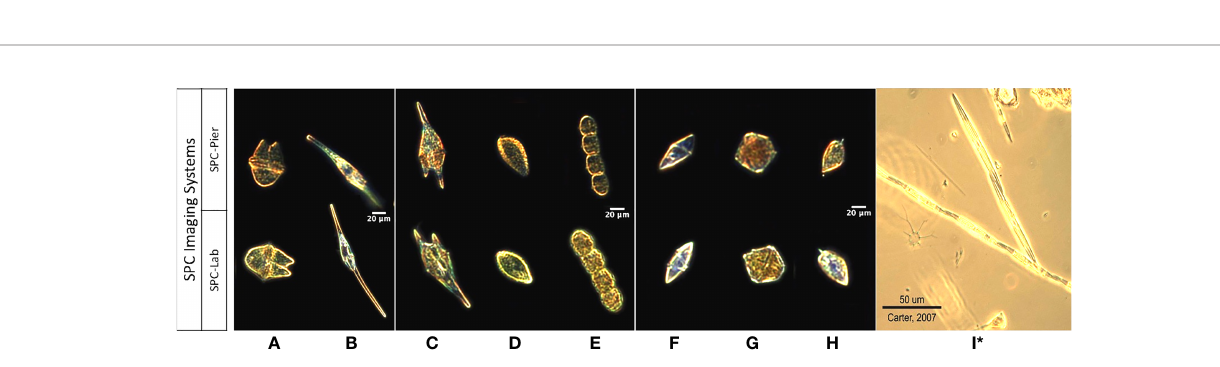
FIGURE 1 | The Imaging Systems. (A) SPC-Pier, SPC-MICRO Underwater Camera. (B) SPC-Lab, Benched laboratory con fi guration of SPC-MICRO.